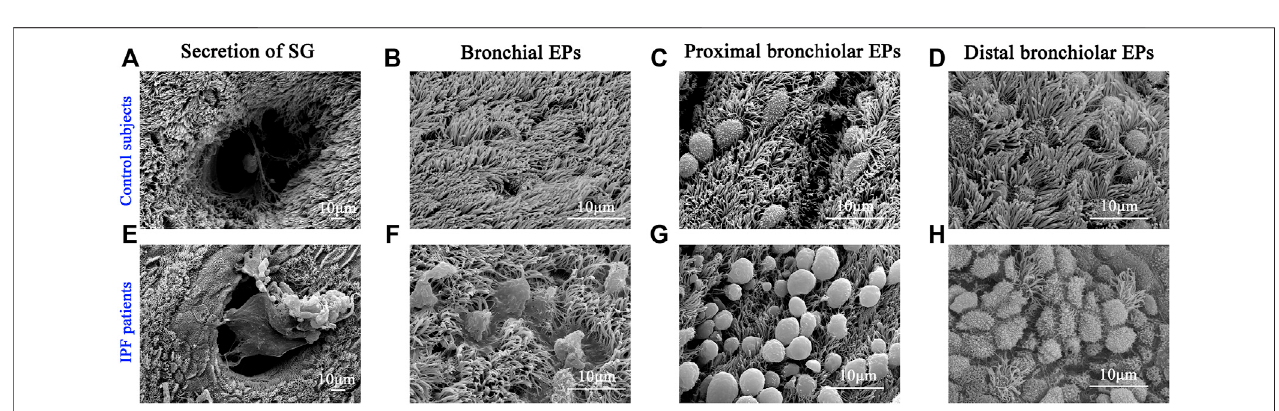
FIGURE 4 | Characteristics of surface epithelium revealed by SEM. SEM was performed to show the distribution of ciliated cells and secretory cells in different regions of conducting airway from control subjects (A – D) and IPF patients (E – H) . IPF, idiopathic pulmonary fi brosis; SEM, scanning electron microscope. EPs, epitheliums; SG, submucosal